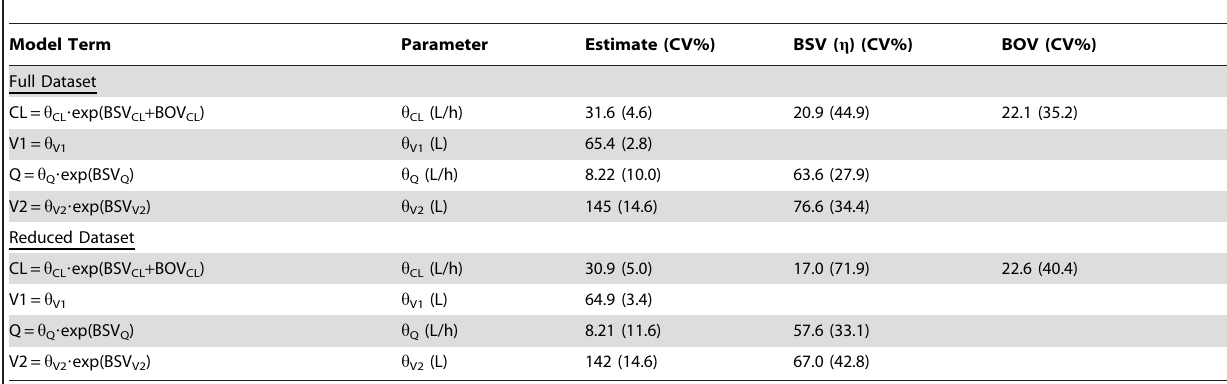
Table 4. Base model PK parameter